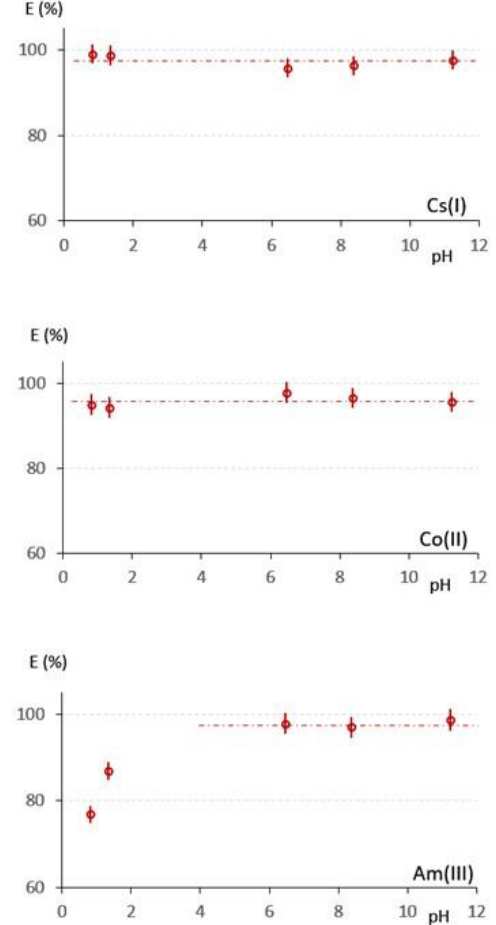
Figure 3. Removal of Cs(I), Co(II) and Am(III) radionuclides from simulated wastewater; an example run for pH = 2.2 ( left ) and the pH dependence ( right ).